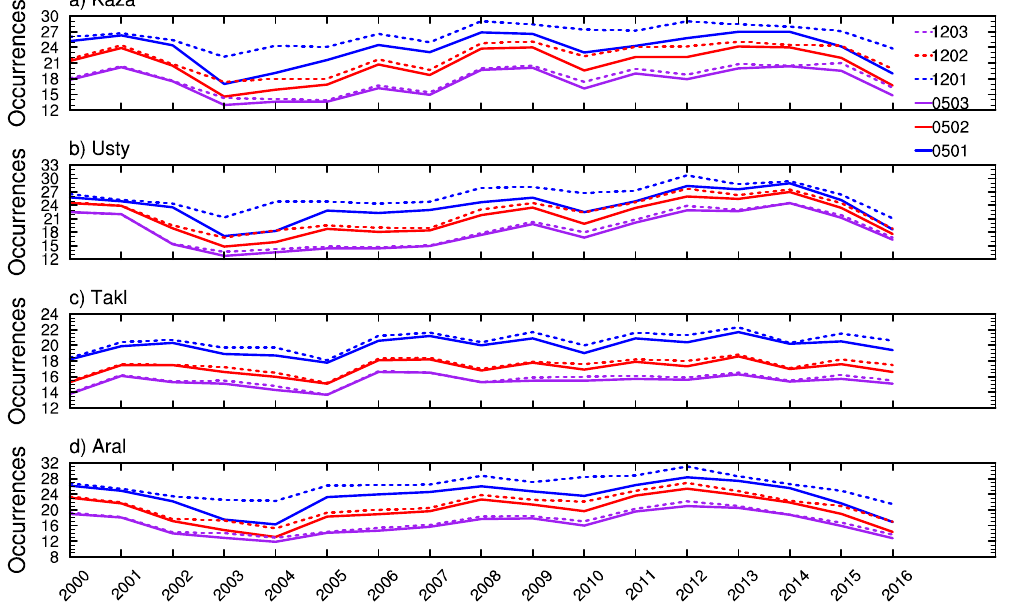
Figure 10. The inter-annual variability of dust occurrences that obtained by applying two AEt and three DODt values to MODIS/Terra AOD over the four sub-regions (( a ) Kaza-Kazandzhik; ( b ) Usty-Ustyurt Plateau; ( c ) Takl-Taklimakan; and ( d ) Aral-Aral Kum) during the 2000–2016 period. The legend labels represent AEt and DODt, for instance, 1203 means AEt = 1.2 and DODt = 0.3. Table 3. Trend (per year) and associated p -values with the confidence interval of 0.95 for dust occurrences derived from MODIS/Terra ADO over the four sub-regions during 2000–2016 by a non-parametric test,